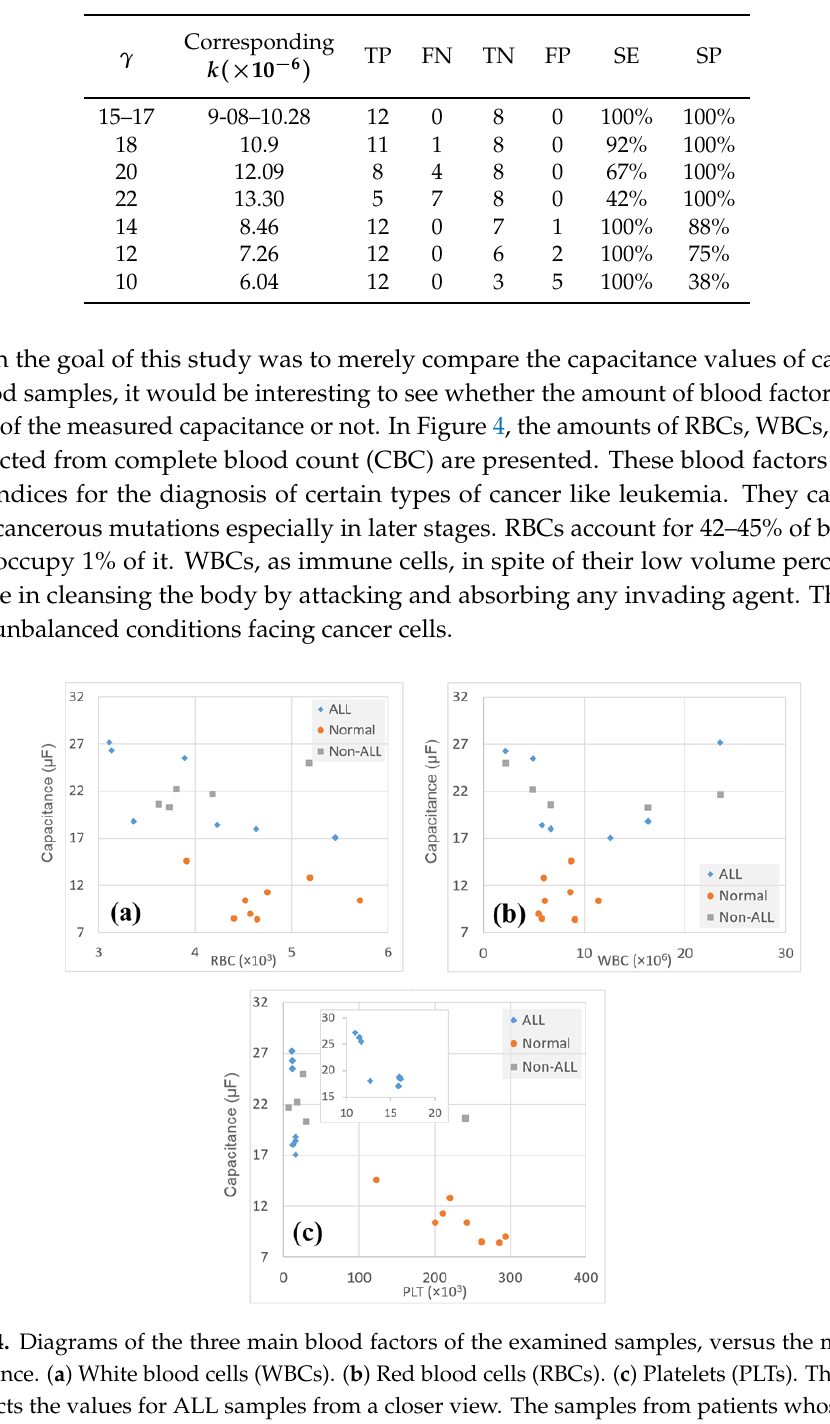
male subjects for the healthy group. The same was true for the patient group: Group A, males: 4.15, females: 3.90; Group B, males: 4.80, females: 4.56. Table 2. Sensitivity (SE) and specificity (SP) analysis on the data presented in Table 1 for different values of γ (gold standard).